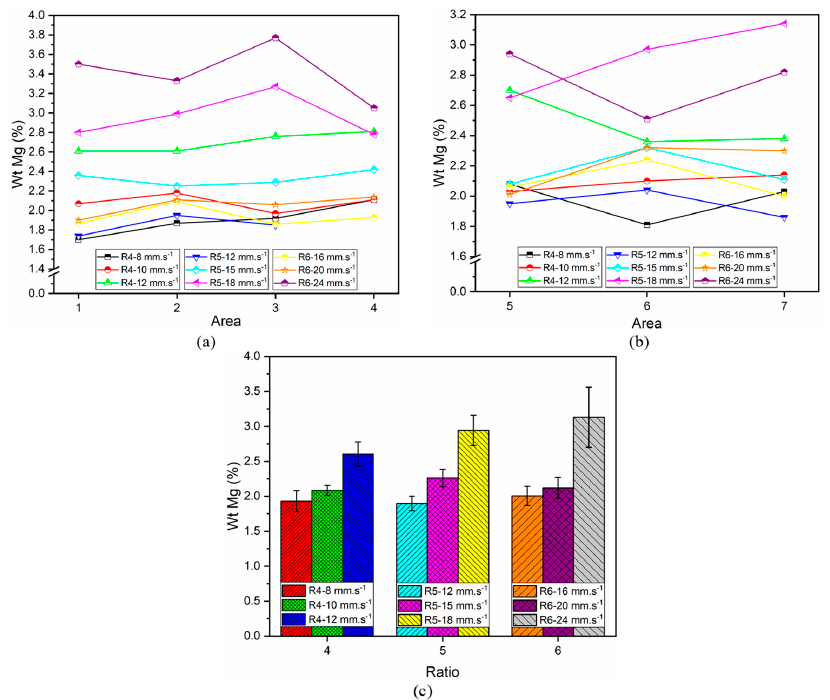
Figure 11. Wt. (%) Mg on all variations of parameters: ( a ) the horizontal axis, ( b ) the vertical axis and ( c ) the average.